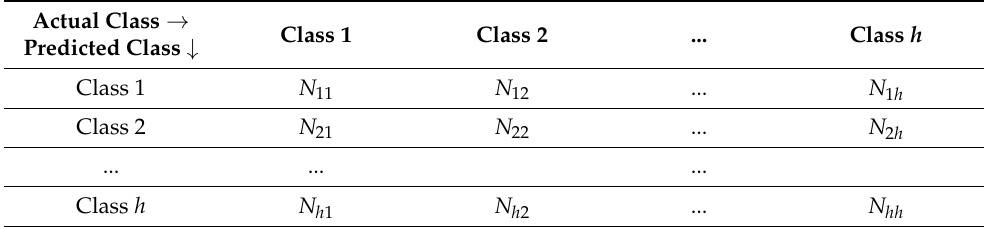
Table 1. Form of the confusion